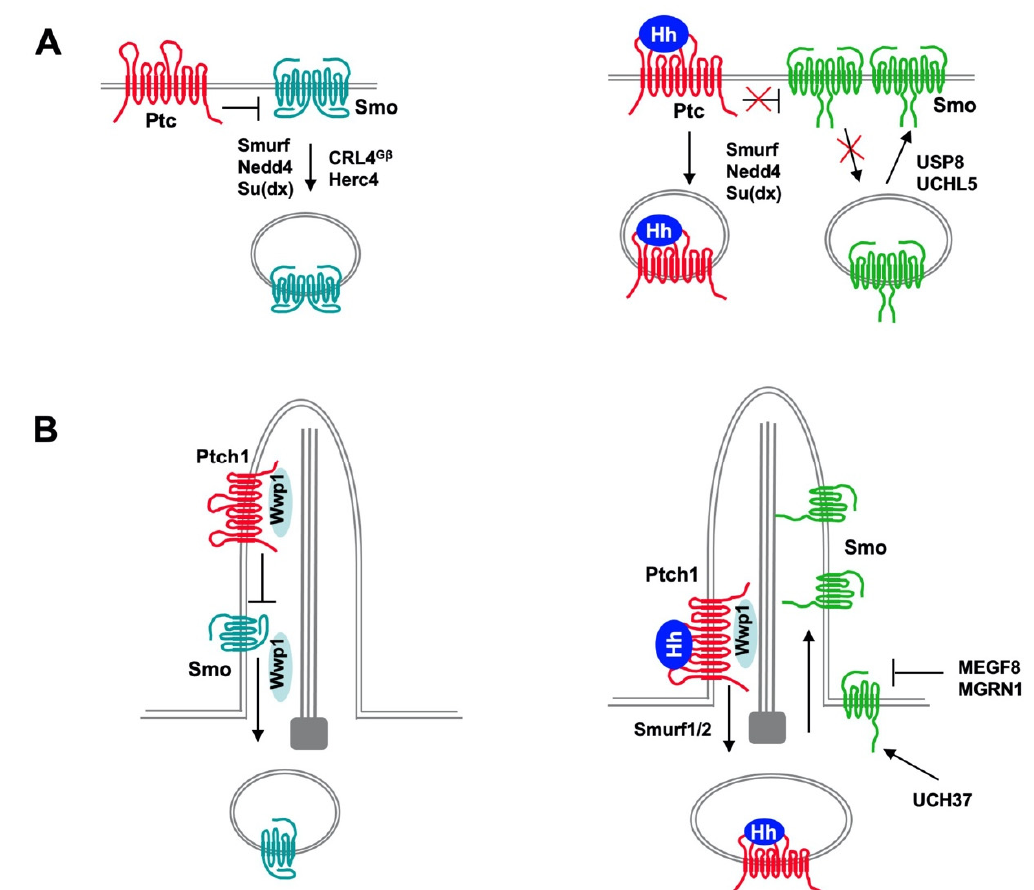
Figure 3. Regulation of reciprocal trafficking of Ptc and Smo by ubiquitination. In both Drosophila and vertebrates, Hh induces reciprocal trafficking of Ptc and Smo through regulating their ubiquitination. ( A ) In Drosophila , Ptc inhibits Smo in the absence of Hh, allowing Smo to be ubiquitinated by multiple E3 ligases including Smurf, Nedd4, Su(dx), CRL4 G β and Herc4, which promotes Smo internalization and degradation by both proteasome and lysosome. Binding of Hh promotes Ptc internalization and degradation mediated by E3 ligases Smurf, Nedd4 and Su(dx). Hh promotes Smo cell surface accumulation through inhibiting its ubiquitination by dissociating E3s and recruiting DUBs USP8 and UCHL5. ( B ) In mammal, Wwp1 is recruited to primary cilia through binding to Ptch1 and ubiquitinates Smo to promote its ciliary exit whereas Hh stimulates Ptch1 internalization and degradation by the E3 ligases Smurf1 and Smurf2. In addition, Smo level is inhibited by HERC4 and a membrane localized E3 complex MEGF8/MGRN1 but increased by the DUB